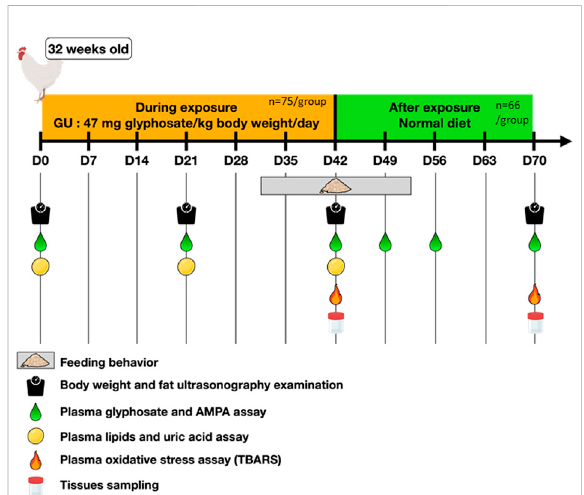
FIGURE 1 Experimentaldesignappliedto hens.Hens(32 weeks old;n= 75) were dietary exposed to GBH (Glyphosate-Based Herbicide, correspondingtoadoseof47 mgglyphosate/kgbodyweight/day, group named GBH) for 42 days straight, then they received a normal diet (not exposed to GBH, same diet, group named ex GBH) for the 28 following days. Their respective controls (CT, n = 75 and Ex-CT, n = 66) received a normal diet for the whole time. During these 70 days, hens were regularly weighed and ultrascanned to determine fat thickness, their feeding behavior was assayed by counting pecks at the diet and their blood was sampled for glyphosate, AMPA, lipids, uric acid and oxidative